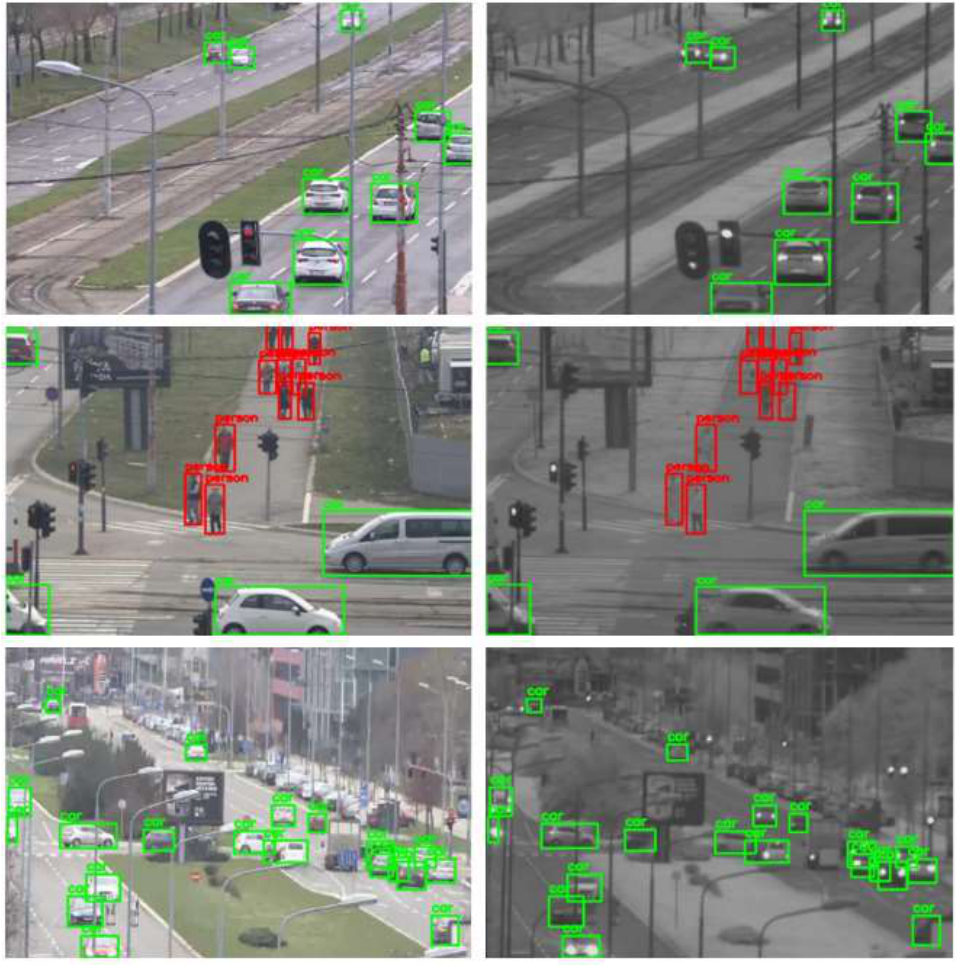
Figure 8. Results of mapping detections (car—green, person—red) from visible-light ( left ) to SWIR ( right ) images using YOLOX-x model for the detection and mapping method explained in Section 4.3. Detection mapping is performed using the YOLOX-x model [14] with an image input resolution of 640 × 640 pixels. The detection acceptance threshold on the color channel is set to 0.3. The obtained detections on the color image are then scaled to the resolution of the SWIR image and transformed using the calculated homography matrix. By applying the inverse transformation, the detections are transferred back to the original domain of the SWIR image. The results of the algorithm for detection mapping from color to SWIR images are shown in Table 4. The results were obtained using the COCO_eval library